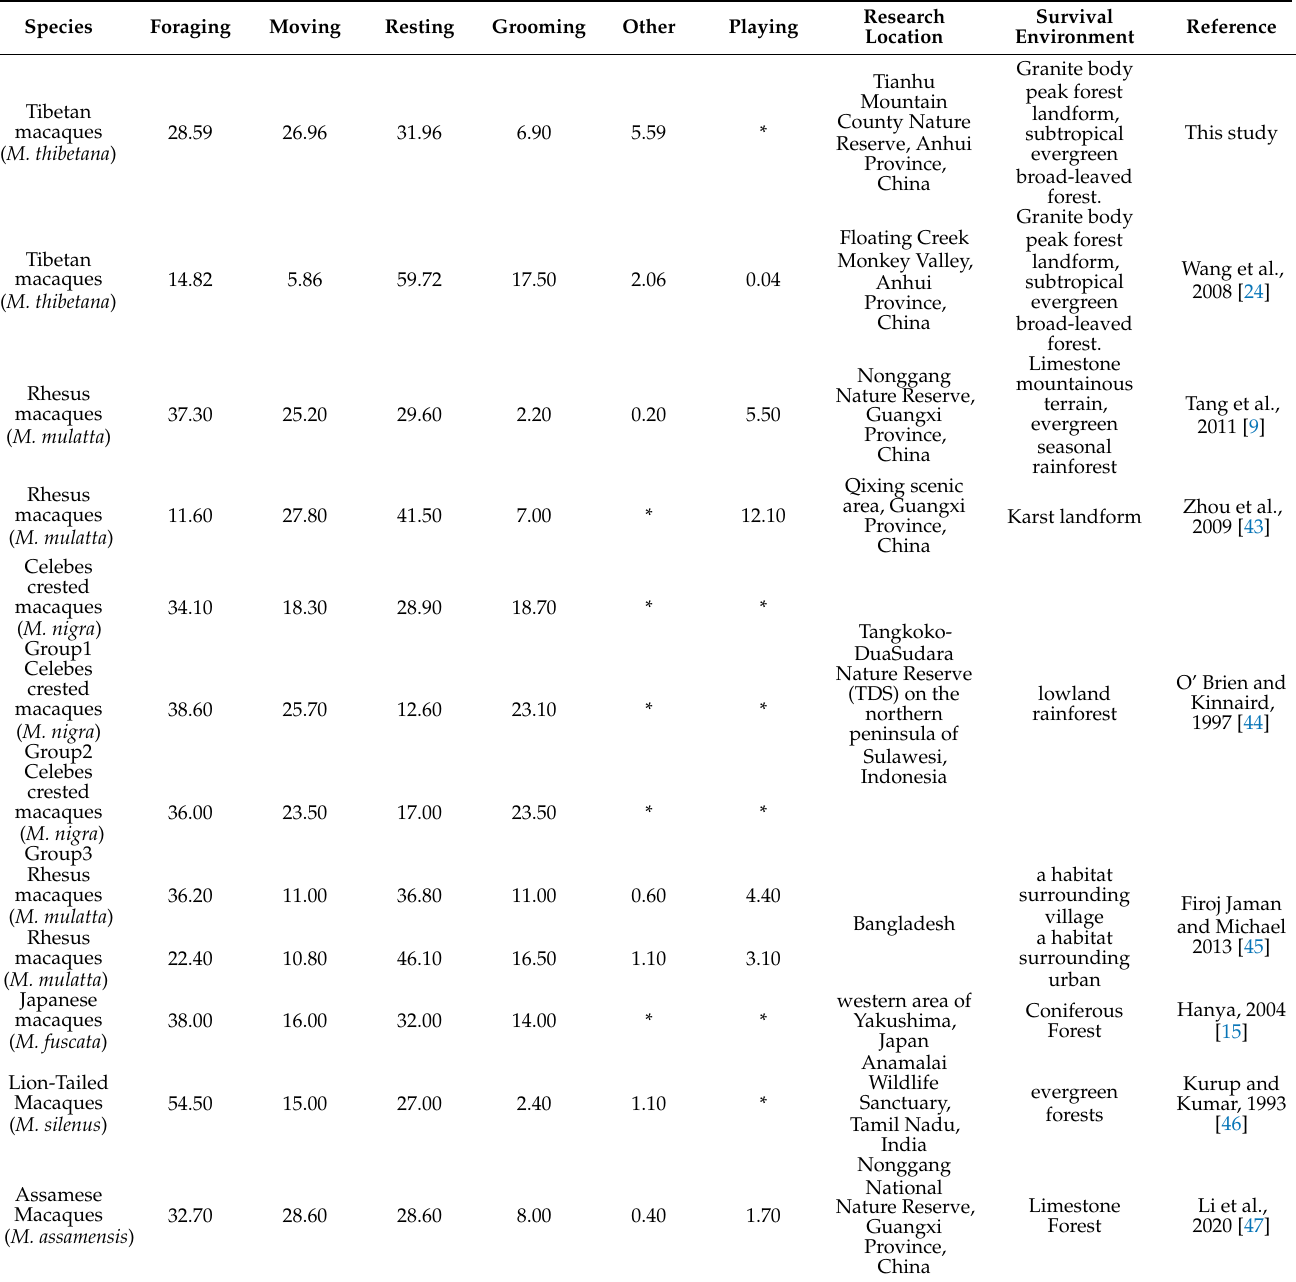
Table 2. Comparison of activity rhythms and time budgets of macaque species in the